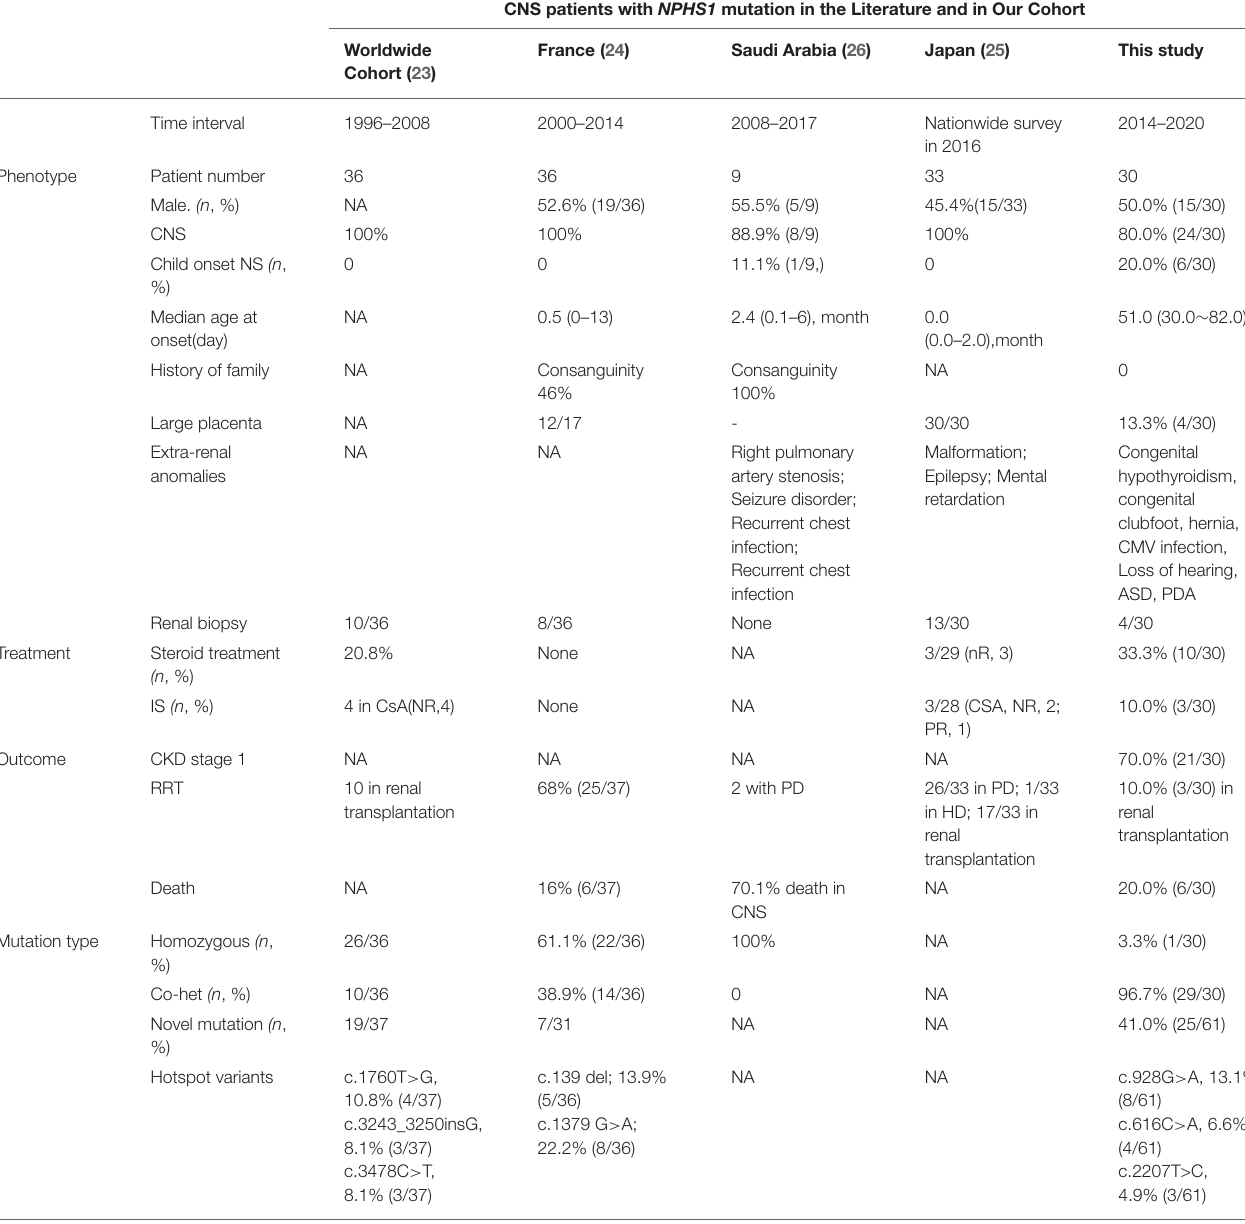
TABLE 5 | Phenotype and genotype of CNS patients with NPHS1 mutation in the literatures and comparison with our